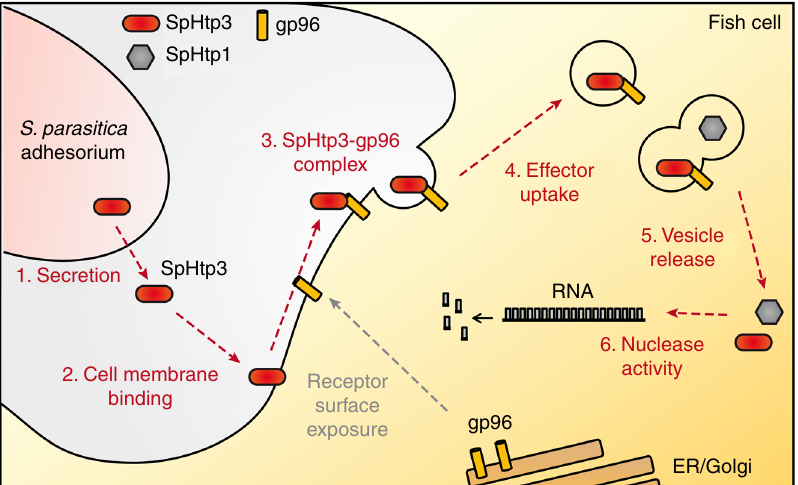
Fig. 8 Model for the self-translocation of SpHtp3 into host cells and its vesicle release. The fi sh-pathogenic oomycete S. parasitica secretes several effector proteins during different stages of infection. The nuclease SpHtp3 is secreted in the later stages of infection. S. parasitica acidi fi es the pH of its environment, which likely leads to the exposure of a gp96-like protein to the host cell surface. The gp96-like protein is working as a receptor and mediates the translocation of SpHtp3 via lipid rafts into the cell. Finally, SpHtp3 is released from vesicles with the help of other effector proteins, as SpHtp1, into the cytosol where it is functionally active as a